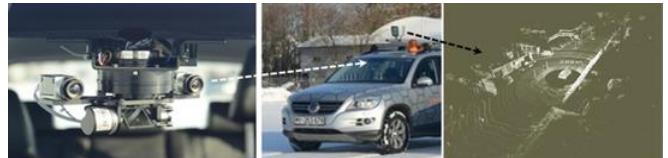
Figure 12. Agile multi-focal camera platform (left) as the main sensor, supported by a high-resolution 360° rotating laser scanner mounted on the roof (center). Right: Laser-image in perspective projection. UniBwM/LRT/TAS [51].